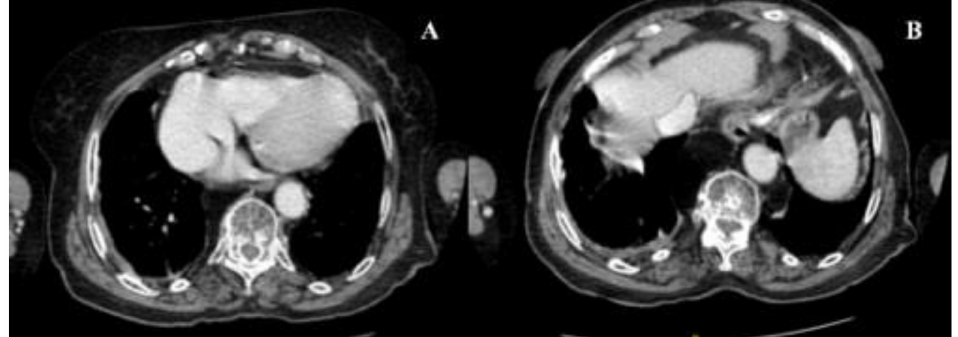
Figure 4. Thoracic-abdominal-pelvic CT, performed after eight cycles of chemotherapy, showing radiological improvement, without lymphomatous masses in right superior lobe ( A ) or right pleural e ff usion ( B